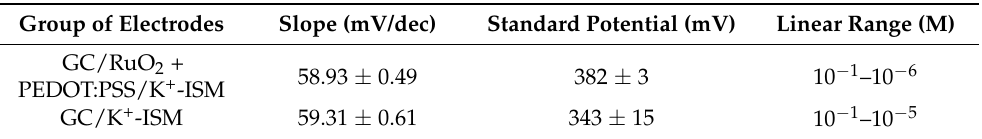
Table 2. Potentiometric response towards K + ions for the group of RuO 2 -PEDOT:PSS-based electrodes and coated-disc electrodes ( n = 3 items), with standard deviation values depicting reproducibility of electrodes’ responses within a group.